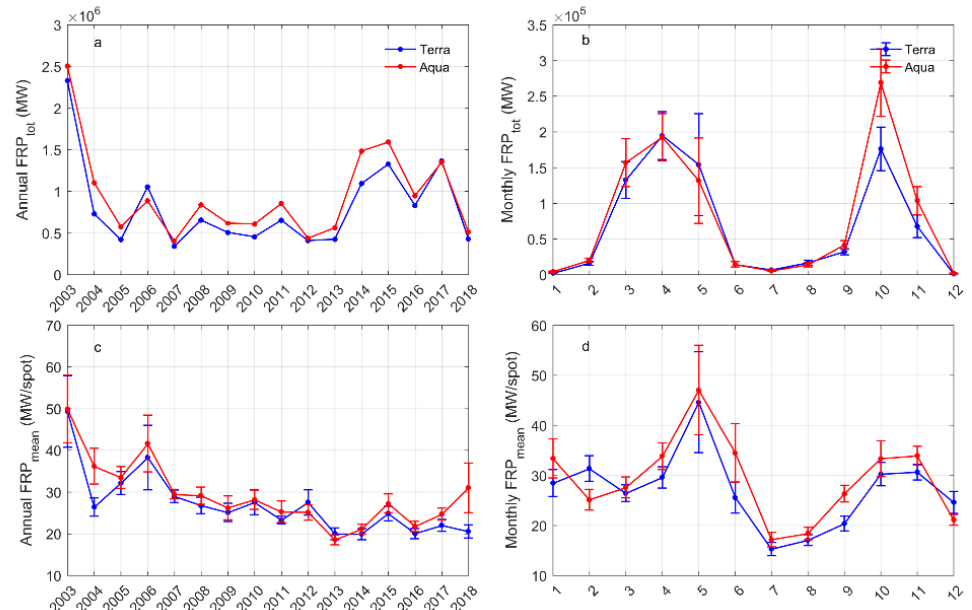
Figure 5. Statistic value of fire radiative power during 2003–2018 in NEC from Terra and Aqua fire products. ( a ) Annual total fire radiative power (unit: MW); ( b ) monthly total fire radiative power (unit: MW); ( c ) annual mean fire radiative power per spot (unit: MW/spot); and ( d ) monthly mean fire radiative power per spot (unit: MW/spot) in NEC. Error bars indicate one-fifth of the standard deviation.